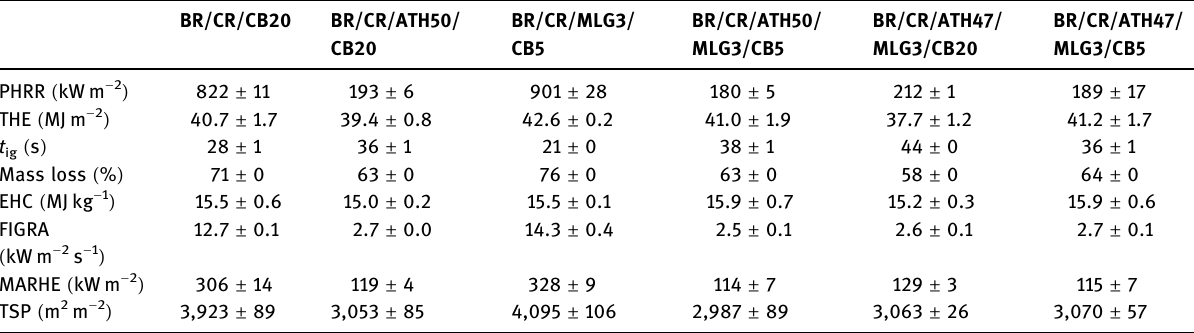
Table 6: Cone calorimeter results of BR/CR